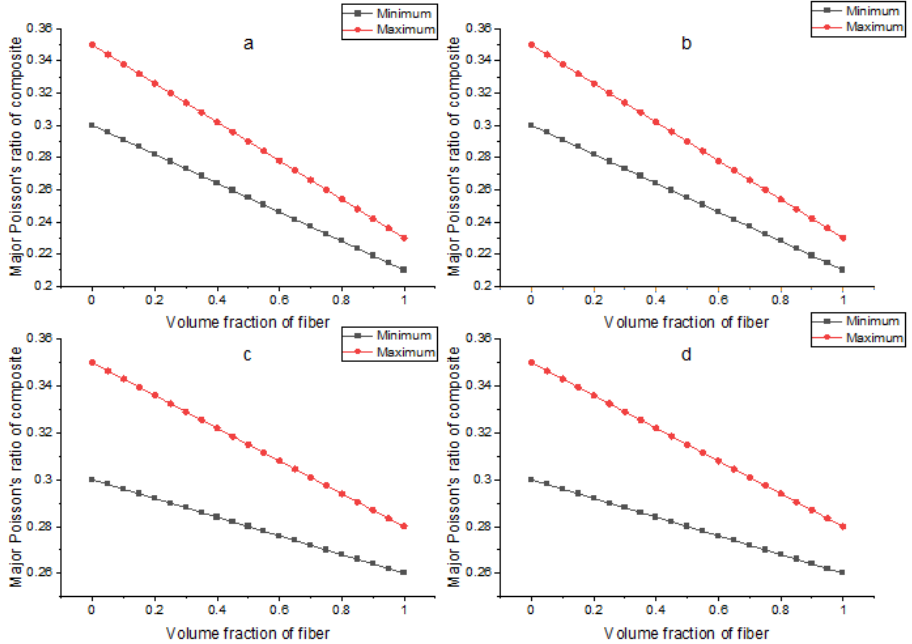
Figure A4. Depicts the variation in the major Poisson ratio of ( a ) E-glass, ( b ) S-glass, ( c ) T300 carbon fiber and ( d ) AS carbon with volume of fiber. It can be seen that the value of the Poisson ratio is maximum at low fiber ratios and starts to decrease as the fiber ratio increases. The trend is similar for all the